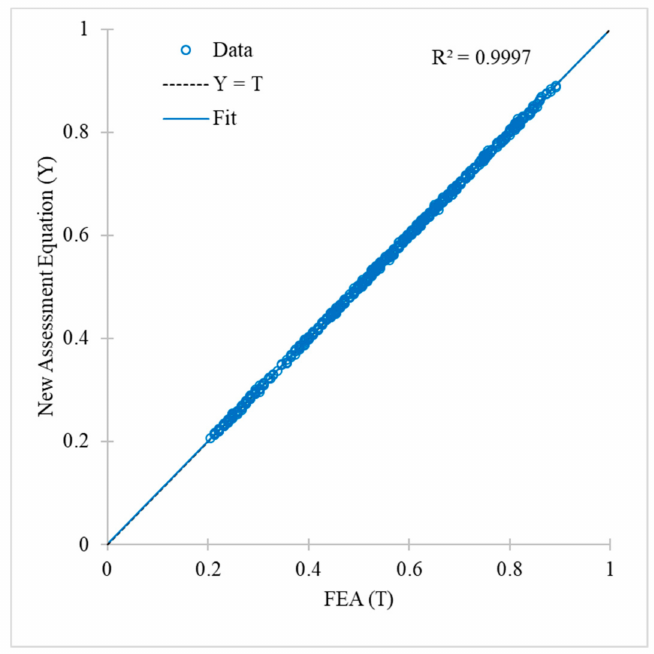
Figure 15. Regression plot of failure pressure predictions made by the new assessment equations and